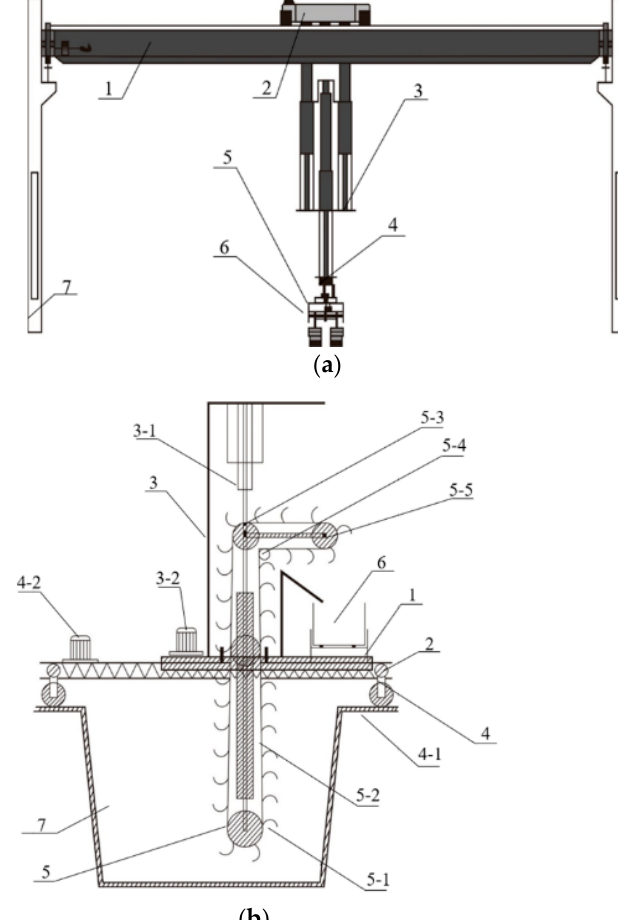
Figure 5. Device for discharging the fermented grains. ( a ) Continuous grabbing device, reprinted with permission from [30]. Copyright 2021 from authors (1, crossbeam; 2, car; 3, elevator component; 4, quick-changing component; 5, rotation component; 6, grains-grabbing device; 7, wall beam); ( b ) continuous lifting device, reprinted with permission from [31]. Copyright 2021 from authors (1, horizontal guide rail; 2, longitudinal guide rail; 3, main rack; 3-1, hydraulic device; 3-2, electric motor; 4, secondary rack; 4-1, roller and fastening device; 4-2, electric motor; 5, device for lifting fermented grains; 5-1, device for scooping fermented grains; 5-2, conveyor; 6, handcart; 7, pit).